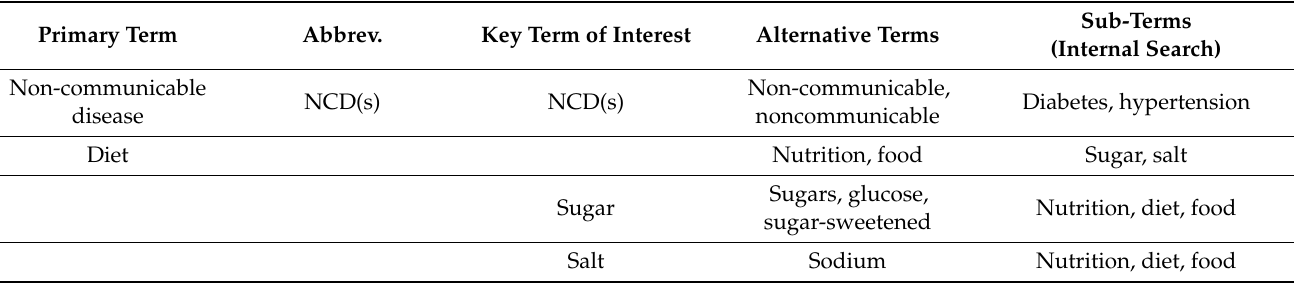
Table 1. Search terms used to explore diet-related policy documents relevant to